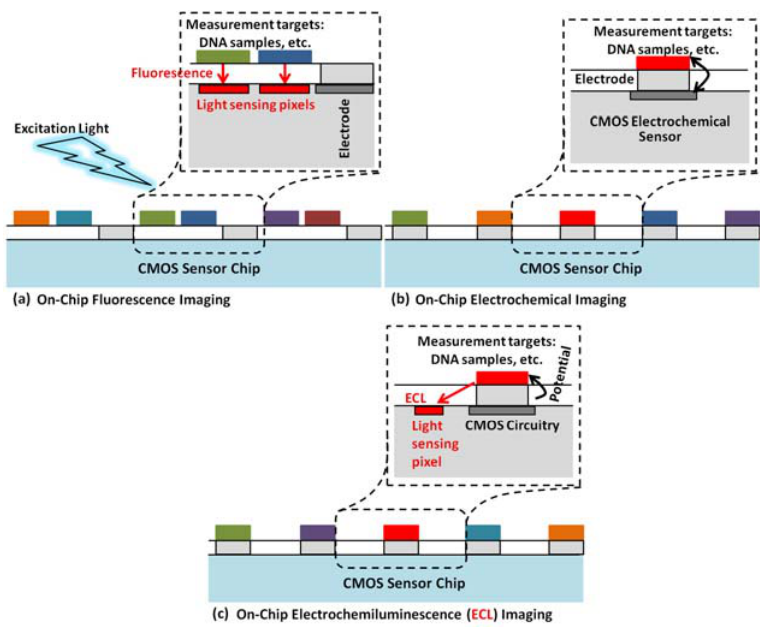
Figure 7. The concept of on-chip biomolecular detection using an optical ( a ) and an electrochemical ( b ) sensor combined in a dual-image CMOS sensor to detect electrochemiluminesence ( c ) [86]. Adapted with the permission of